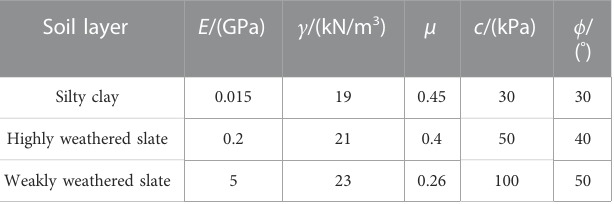
TABLE 1 Soil layer